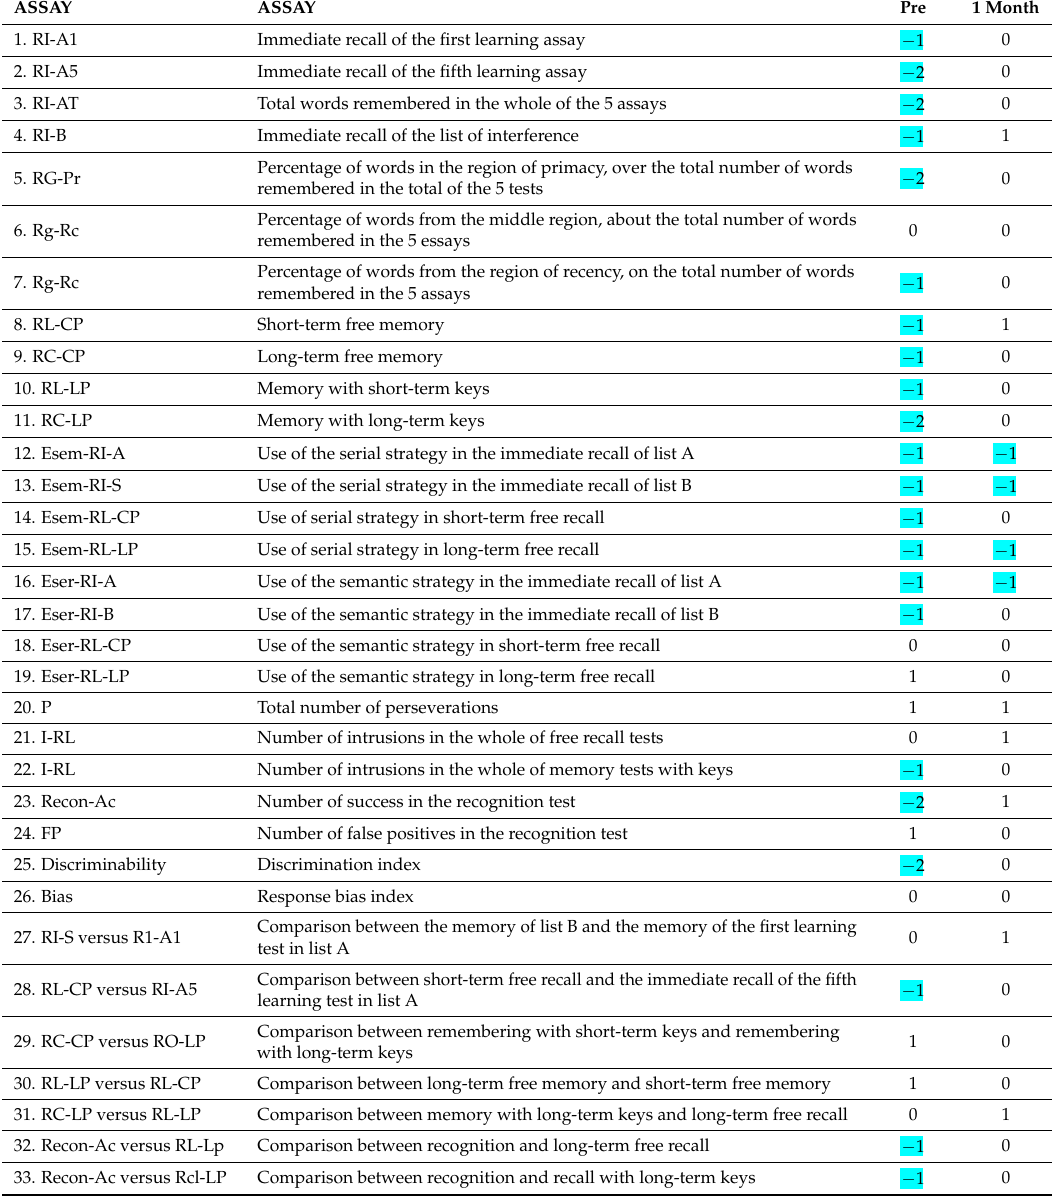
Table 1. Results obtained in the TAVEC test performed in basal conditions (Pre) and 1 month later (seven days after finishing the treatment with GH). The values in the first and second tests correspond to Z-scores (the average value for a normal population is 0). The scores in the first test were, in general, lower (highlighted in blue color) than the average of the normal subjects, indicating a mild cognitive deficit. However, the second test indicates that most of the results obtained are now in the average range for normal subjects or even higher than the